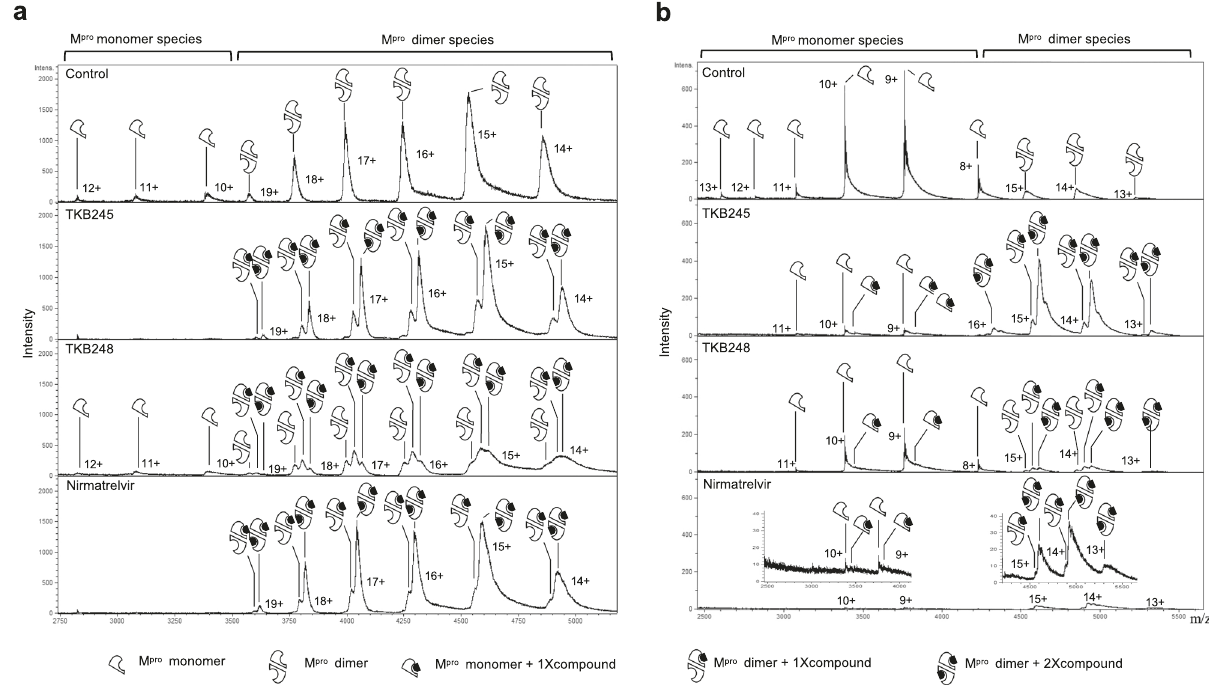
Fig. 3 | Native mass spectrometric analysis of SARS-CoV-2 M pro -inhibitor inter- action. a Authentic M pro (7.5 µ M) was treated with 15 µ M of each indicated com- pound.RelativenativemassspectraoftheM pro withorwithoutTKB245,TKB248,or nirmatrelvirareshown.Chargestates10 + ,11 + and12 + areannotatedtomassspectra correspondingtoM pro monomerspeciesandchargestates14 + ,15 + ,16 + ,17 + ,18 + and 19 + are annotated to mass spectra corresponding to M pro dimer species. b Glycine-